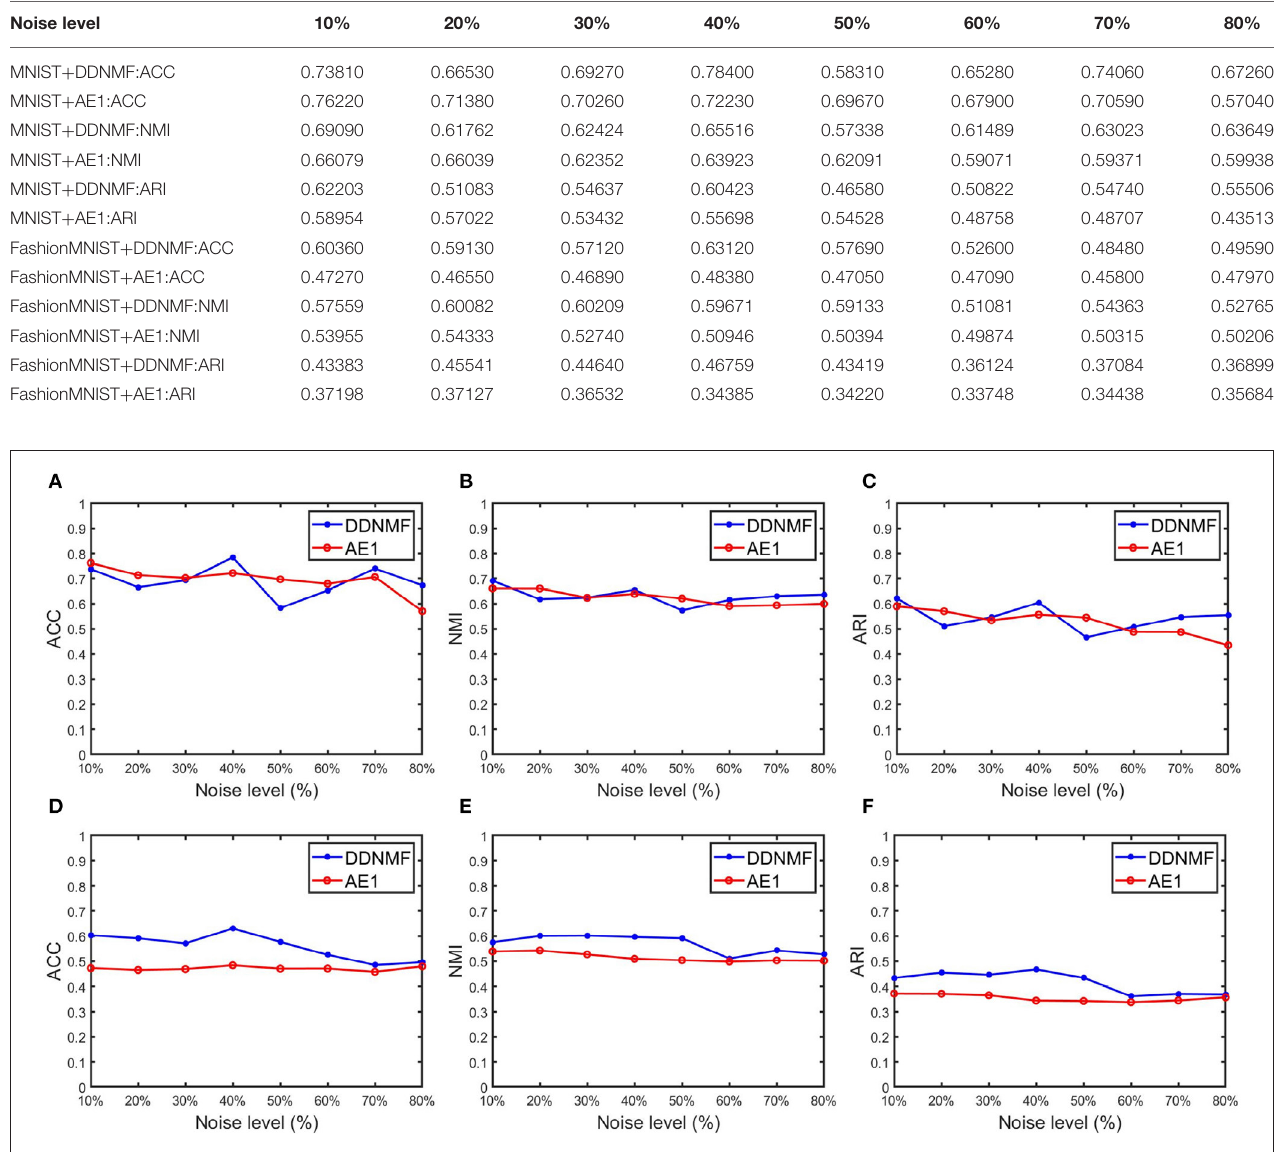
FIGURE 3 | The changes of clustering performance of DDNMF and AE1 on different noise levels. (A–C) Results on the MNIST dataset, and (D–F) are on the FashionMNIST dataset.